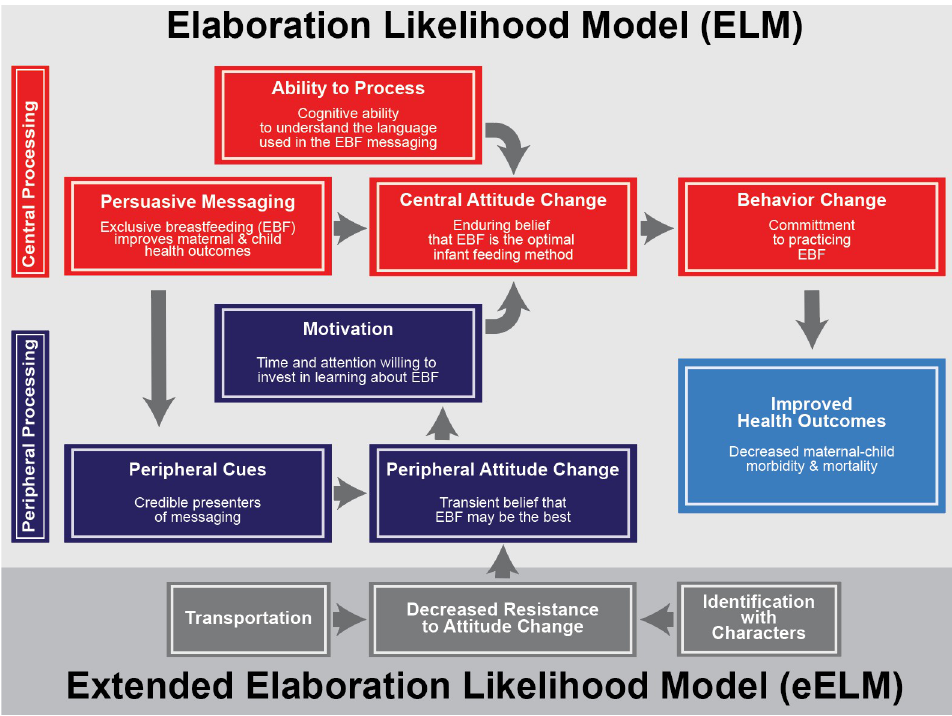
Fig 4. Theory of change. EBF, exclusive breastfeeding; eELM, extended ELM; ELM, Elaboration Likelihood Model.